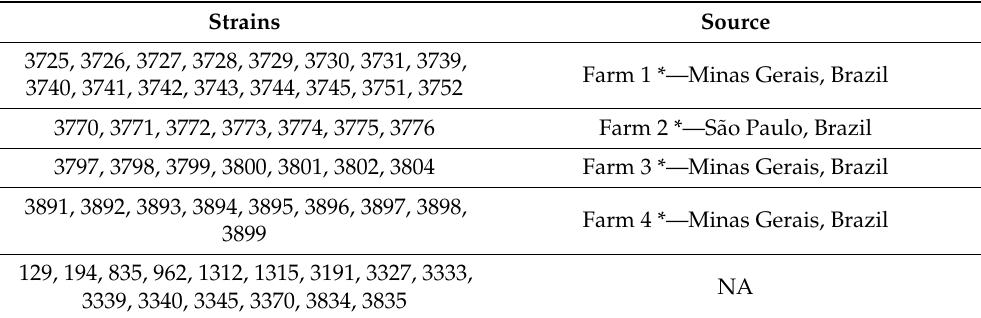
Table 1. Streptococcus agalactiae strains tested for antimicrobial substances production. Strains Source 3725, 3726, 3727, 3728, 3729, 3730, 3731, 3739, 3740, 3741, 3742, 3743, 3744, 3745, 3751, 3752